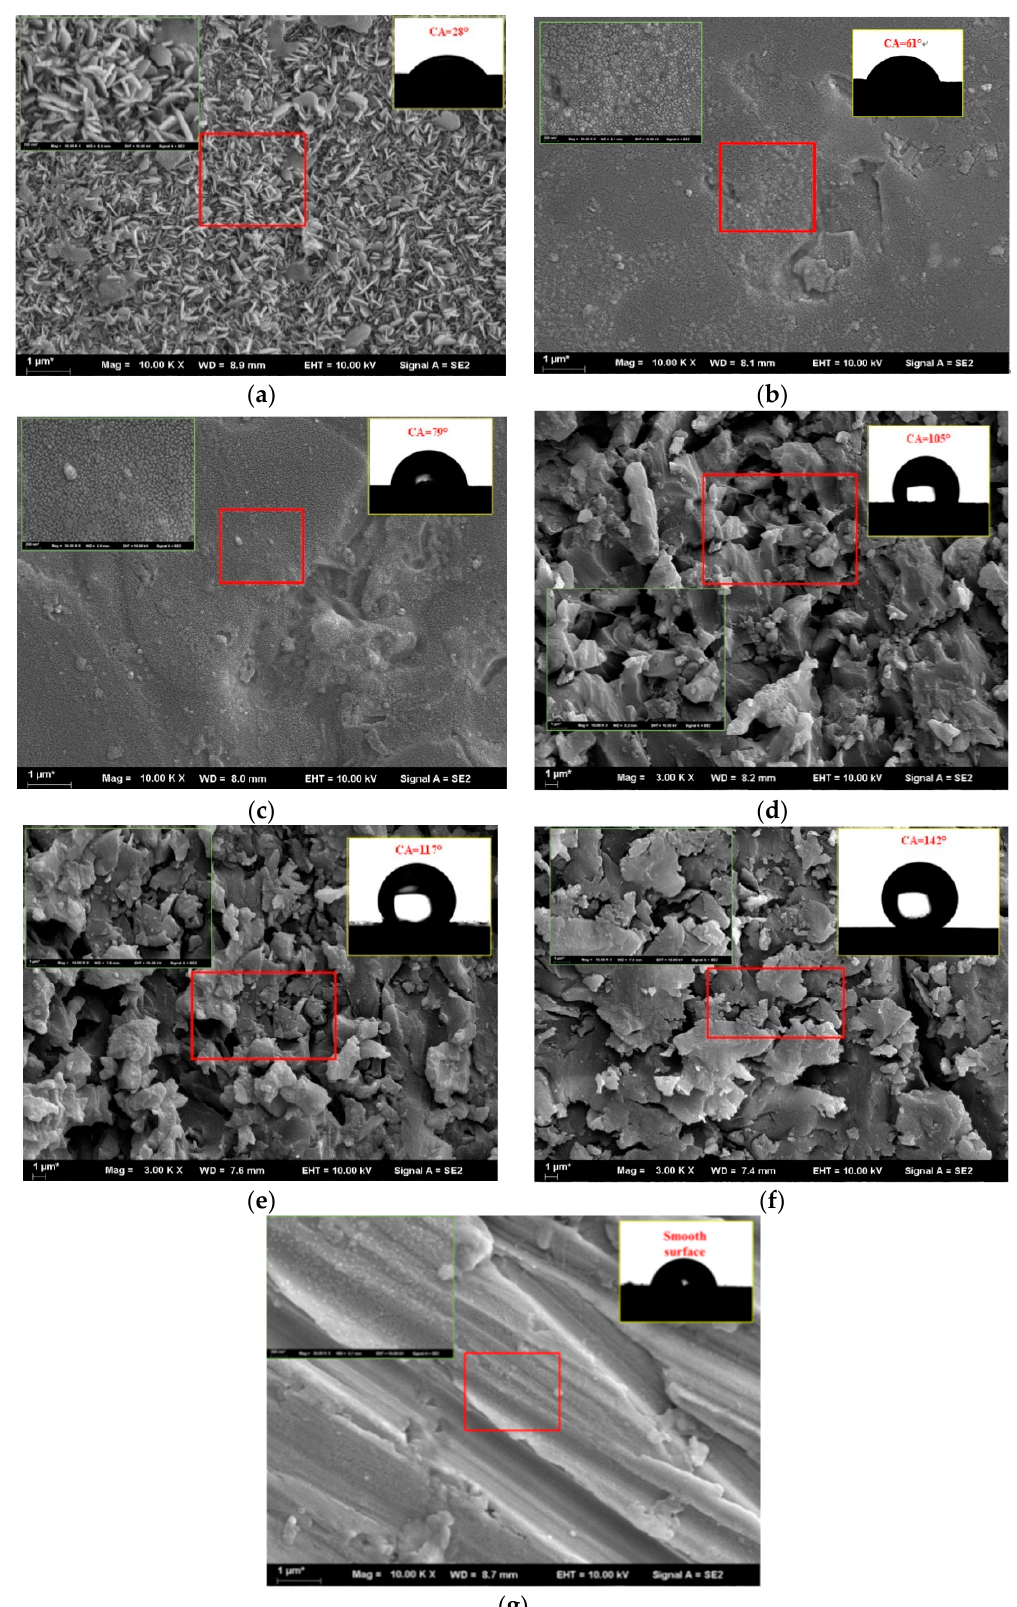
Figure 5. Scanning electron microscopy (SEM) images of: ( a – f ) hydrophilic and hydrophobic surfaces with contact angles (CAs) of 28°, 61°, 79°, 105°, 117° and 142°, respectively, and ( g ) smooth surface (inset: 4 μL of water droplet with static CA).